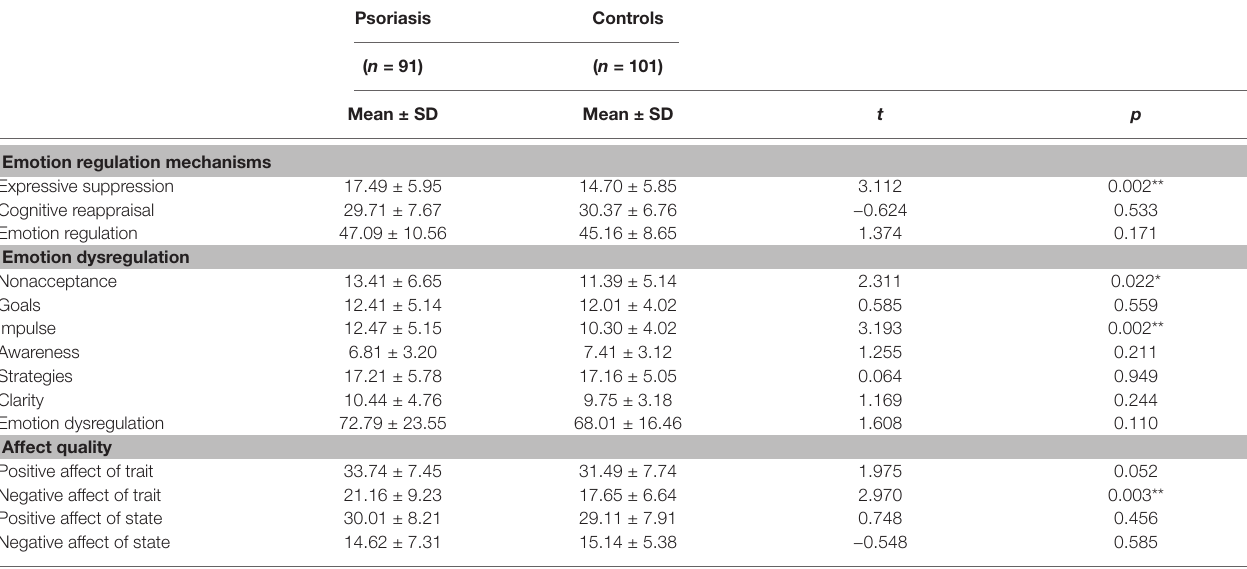
TABLE 3 | Emotion assessment in the two groups (psoriasis patients and controls).